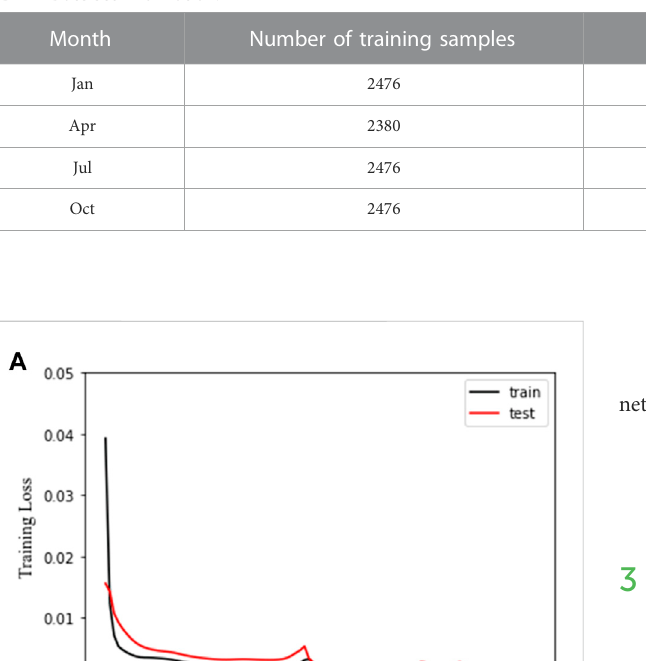
TABLE 1 Date set information.